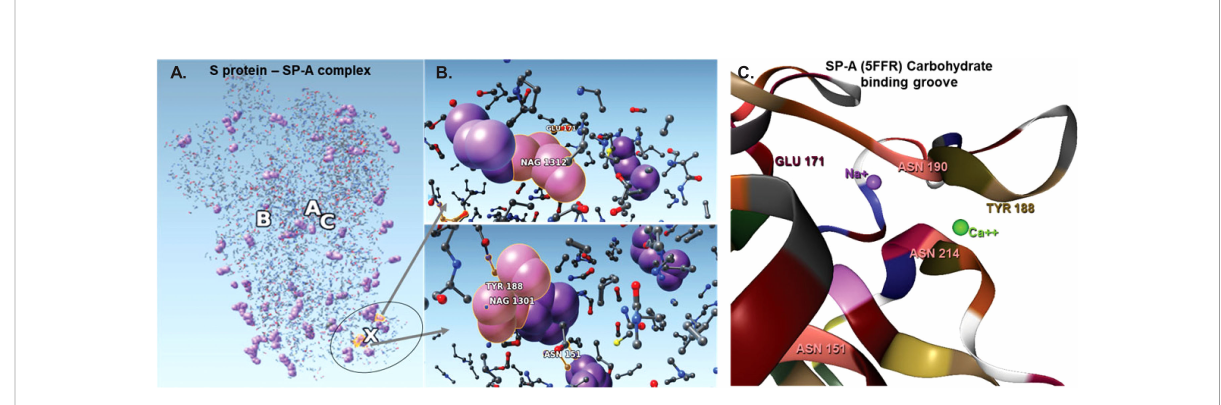
FIGURE 4 The complex resulting from docking of reduced structures of the S protein and SP-A with ZDOCK highlighting the top ranked binding sites on SP-A. (A) : Visualization by SAMSON after clashes/contacts with less than 2 Å distance were identi fi ed using the Chimera program. (B) : The top 5 binding sites are shown (ball and stick) highlighting bound NAG (purple space fi ll balls). SP-A and S protein amino acid residues are shown as a ball and stick. NAG1301 is bound to ASN1134 on the S protein and is shown in close proximity to ASN151 of SP-A. (C) : The SP-A carbohydrate binding grove showing the amino acids identi fi ed in the pruned complex including ASN 151 (pink) TYR 188 (khaki), GLU 171 (bordeaux) and Ca++ (green) and Na+ (purple). ASN 151 is clustered with ASN 214 and ASN 190 amplifying carbohydrate binding ability. The groove is fl anked by TYR 188 and GLU 171 and harbors a Ca++ and a Na+ ligand. Presence of Ca++ is known to be required for carbohydrae binding. Atoms represented by the balls and stick are: (O): red; (C): grey; (Ca): green; (Na): purple; (S):